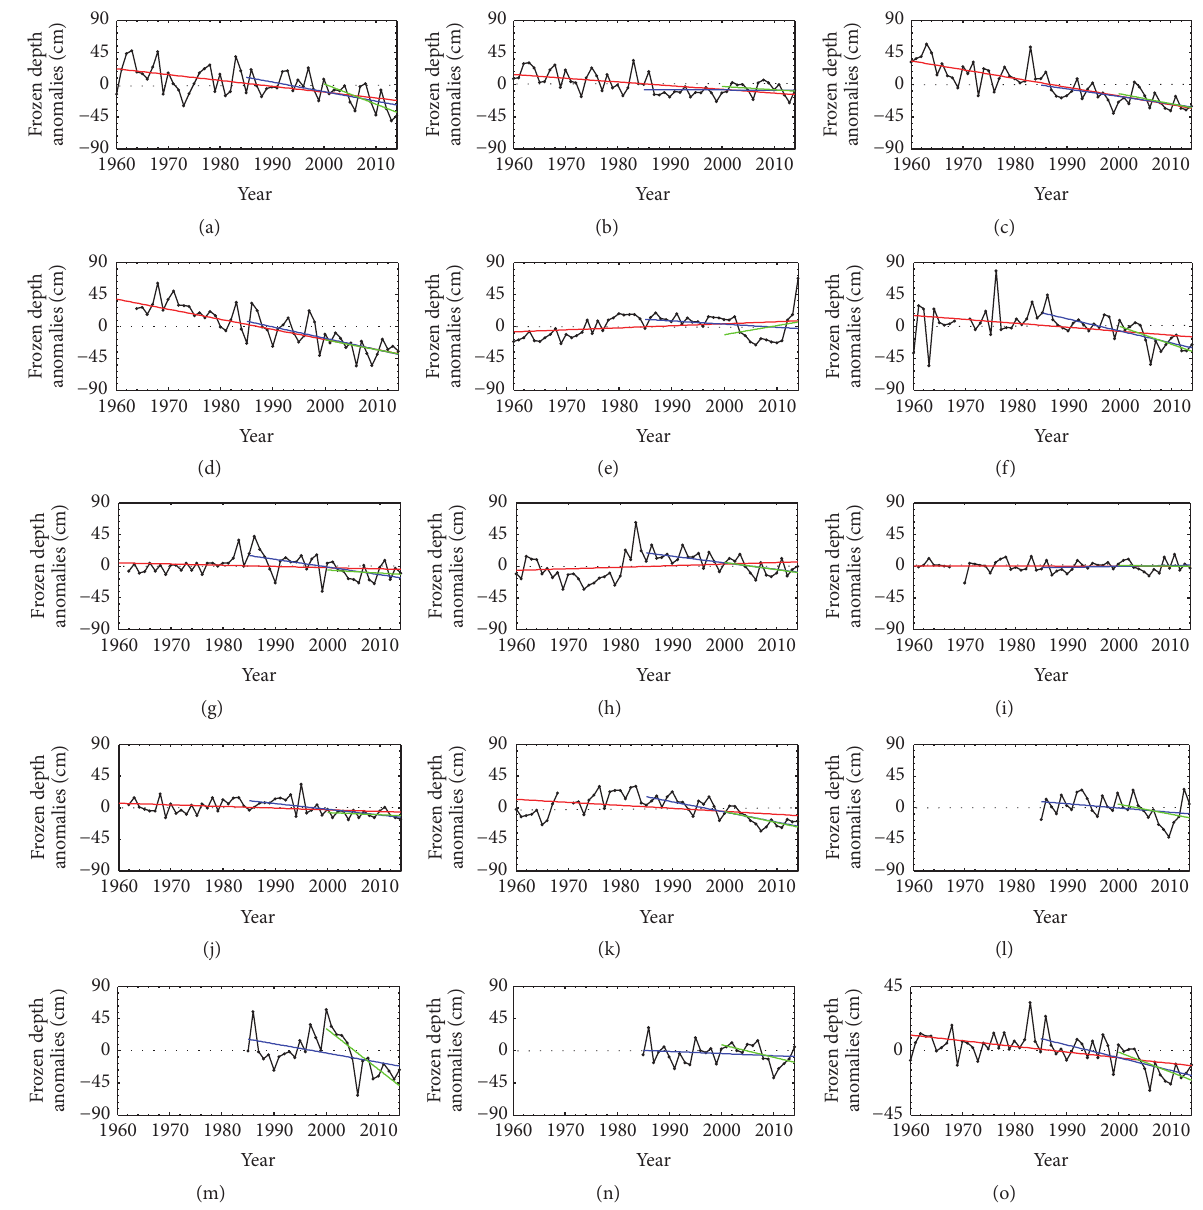
Figure 3: Freeze depth anomaly series during 1960–2014. Linear least squares regression lines are included for 1960–2014 (red line), 1985–2014 (blue line), and 2000–2014 (green line). (a) Xinghai station, (b) Tongde station, (c) Zeku station, (d) Zaduo station, (e) Yushu station, (f) Guoluo station, (g) Dari station, (h) Henan station, (i) Ruoergai station, (j) Nangqian station, (k) Changdu station, (l) Zhiduo station, (m) Qumalai station, (n) Maduo station, and (o)